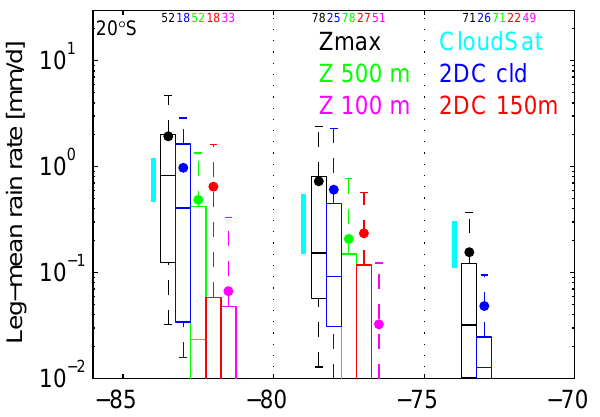
Fig. 17. Longitude-binned C130 broadband longwave radiative flux component boxplots from above-cloud and below-cloud 20 ◦ S legs. Bottom: Inferred mean longwave radiative flux divergence across the boundary layer, 1 LW [Wm − 2 ], for each longitude